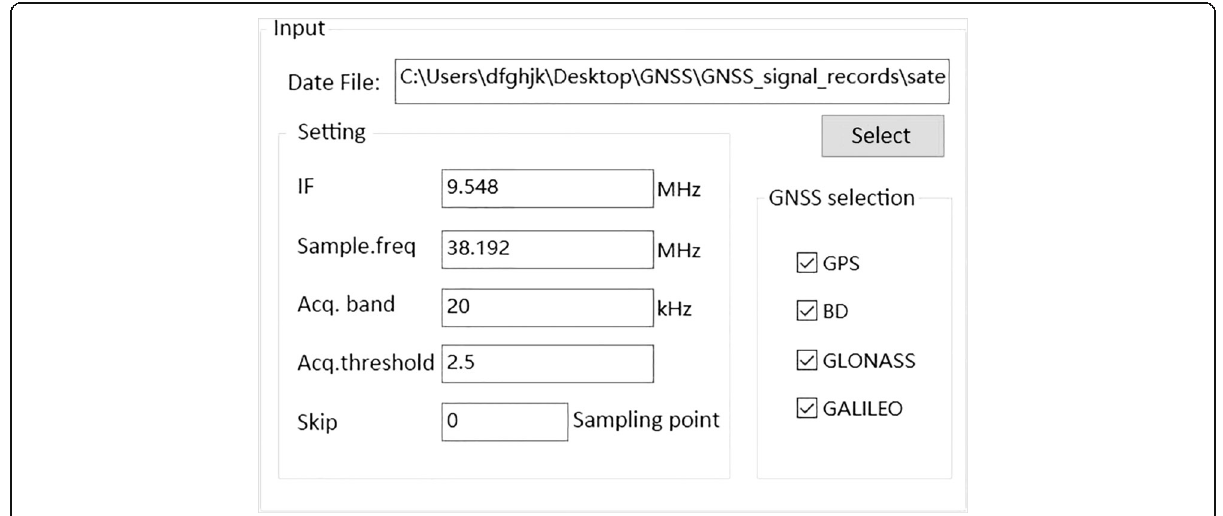
Fig. 6 Acquisition parameter setting interface. This figure shows the interface of the system, where the user can configure the capture parameters through the interface before the capture starts